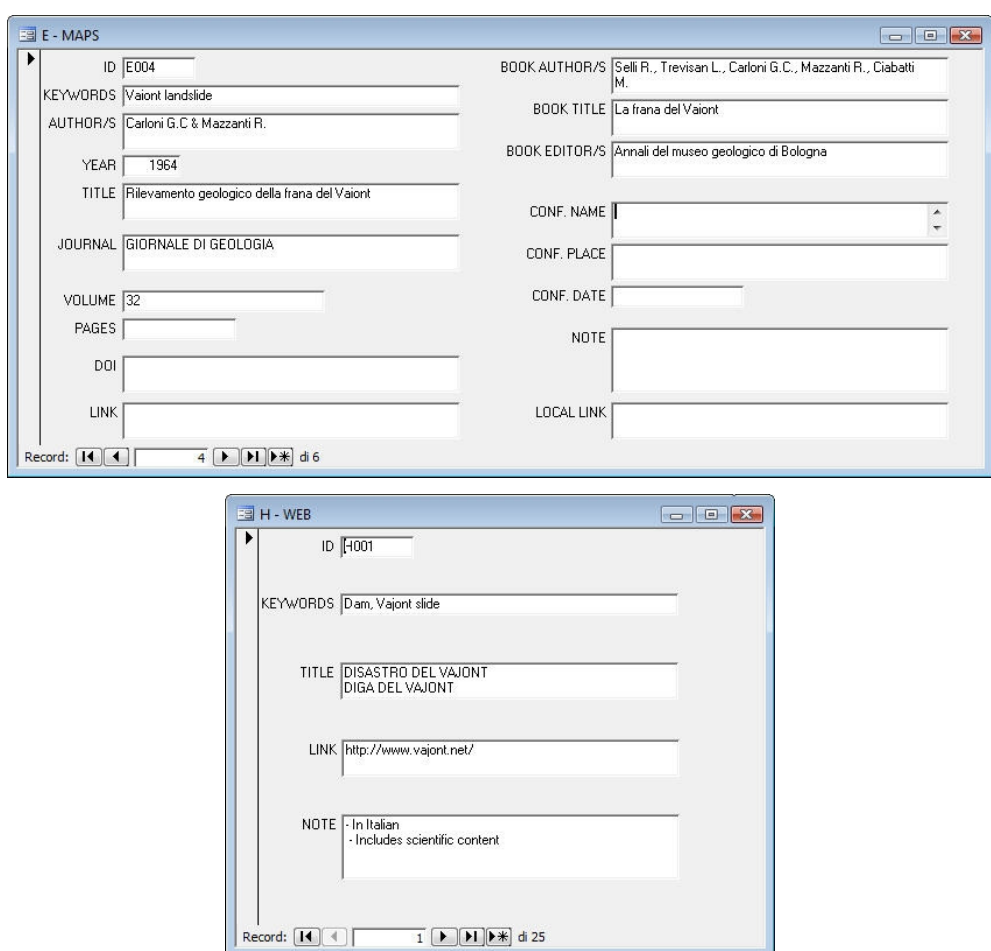
Fig.3b. Input masks created for inserting and visualizing references to maps (E) and web site (H). Input mask of unpublished reports (F) and other (newspaper articles, conference presentations and relevant material) (G) are similar to that for maps (E). document of data from geological and geomechanical sur- veys, geotechnical data from laboratory tests and scientific contents, is reported (Fig.